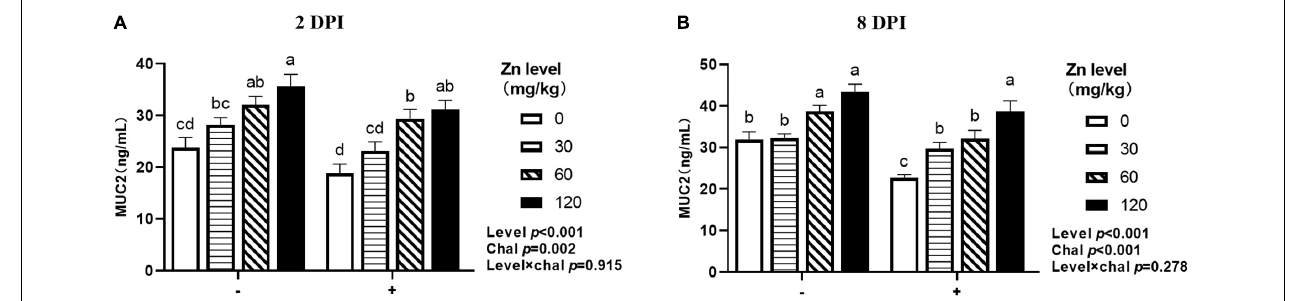
FIGURE 9 | Effect of dietary Zn–Met levels on jejunum 2DPI MUC2 (A) and 8DPI MUC2 (B) concentration of meat duck challenged with APEC. Bars with different letters are statistically significant ( P < 0.05). Results are expressed as mean ± SEM ( n = 6). TABLE 7 | Effect of dietary Zn–Met levels and APEC challenge on the cecal bacteria of meat ducks (8 DPI). Items Total bacteria Bacillus Bifidobacterium Escherichia